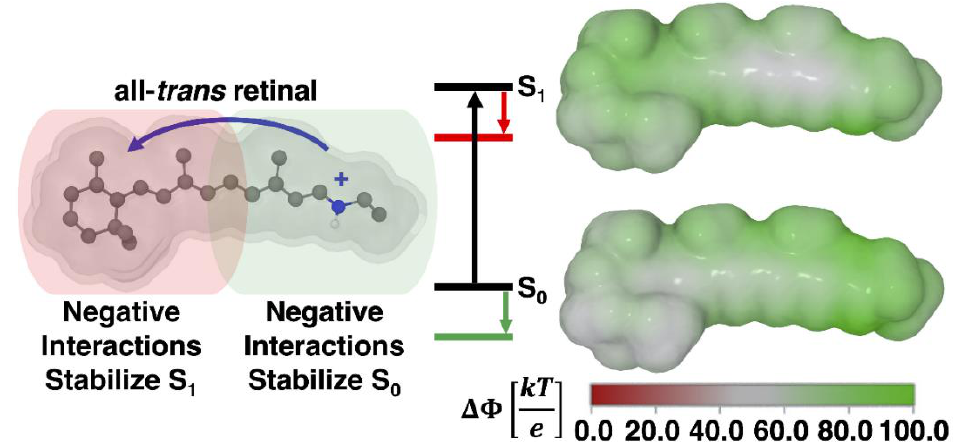
Figure 7. Point charge model schematic for the gas-phase all- trans retinal chromophore. Here, the electrostatic potential ( ΔΦ ) shows a positive charge as green. The schematic shows that the positive charge in the ground state (S 0 ) is localized near the Schiff base. Upon excitation to the first excited state (S 1 ), the positive charge of the protonated Schiff base moves towards the β -ionone ring.